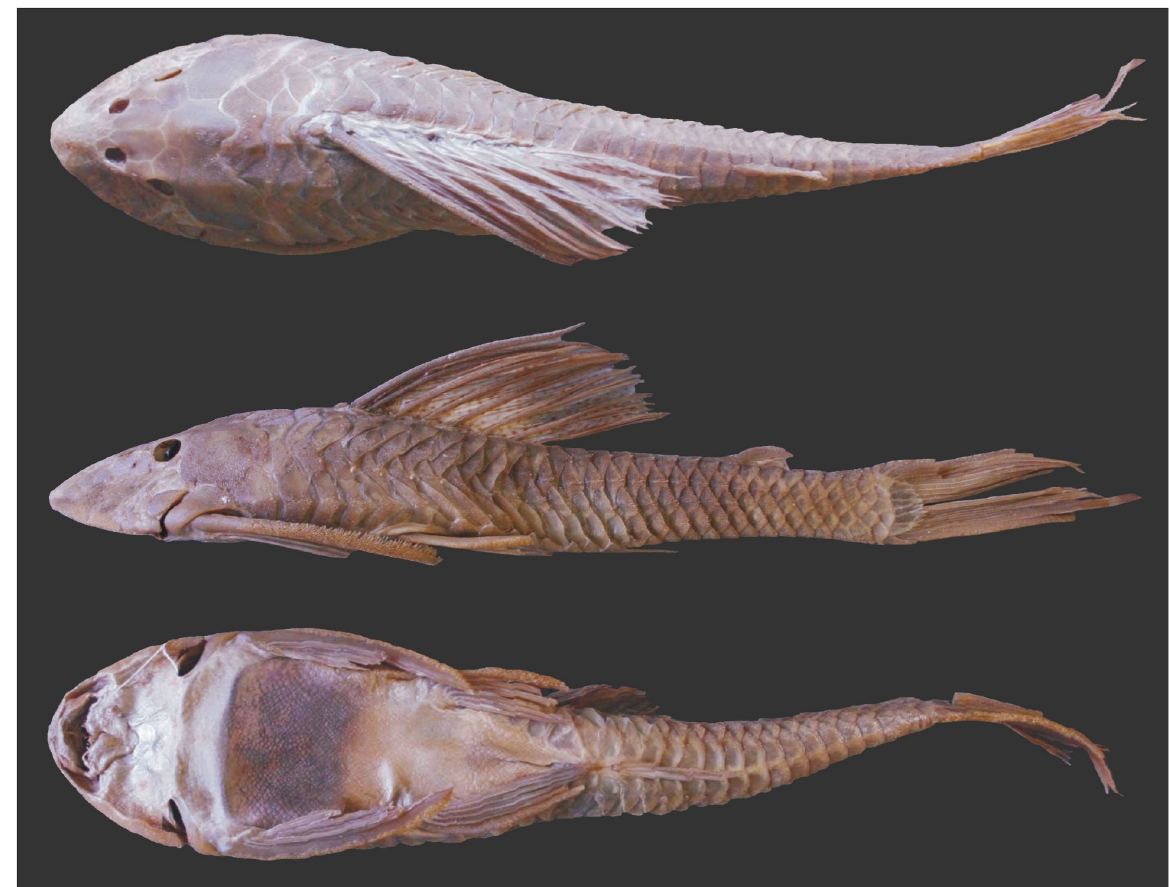
Fig 1. Hypostomus subcarinatus , MNHN A, 9575, 241.8 mm SL, holotype, Brazil, Province de Mines [state of Minas Gerais]. tapering slightly, straight from pelvic-fin insertion to first ventral caudal-fin procurrent ray. Anterior portion of caudal peduncle rounded with its dorsal surface compressed; posterior portion ellipsoid. Mesethmoid forming weak longitudinal bulge from snout tip to nares. Supraoccipital bone with slightly-developed median ridge and short posterior process bor- dered by single plate. Weak bulge originating lateral to nares, passing through supraorbital, and extending as ridge along dorsal portion of compound-pterotic. Opercle large, its horizon- tal length equal to distance between nares, with thin skin layer surrounding its ventral edges to subocular cheek plates. Oral disk round, moderate in size; its margins smooth. Lower lip fall- ing short of transverse line through gill openings; ventral surface with two or three transverse dermal flaps posteriorly margining each dentary ramus; short naked area followed by larger area with numerous small papillae decreasing in size distally. Maxillary barbel moderately long, slightly larger than eye to nare distance; mostly free from lower lip. Odontodes present on anterior surface of upper lip, just below snout. Dentaries moderate to strongly angled, aver- aging from 90˚ to 100˚ between left and right dentary rami. Teeth viliform, bicuspid with lat- eral cusp smaller than mesial cusp; crown bent inward. Internally to mouth, transversal areas of short papillae bordering each premaxillary and dentary teeth rami. Median buccal papilla present and well developed.